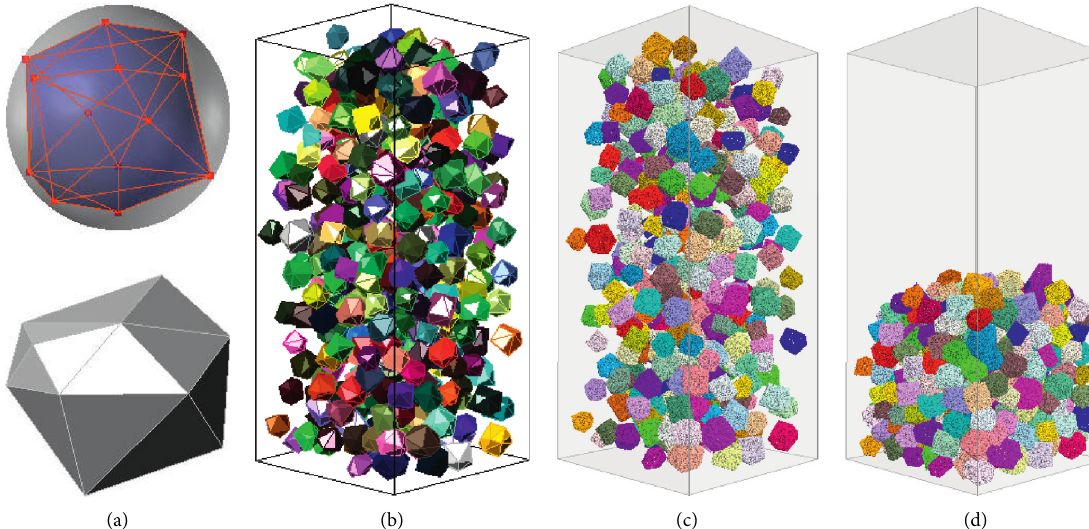
Figure 6: Generation of a sphere clump model for an assembly of polyhedral particles: (a) construction of a polyhedral particle based on a sphere; (b) an assembly of polyhedral particles constructed based on different spheres; (c) the corresponding sphere clump model imported in PFC3D; (d) the sphere clump model after settlement under